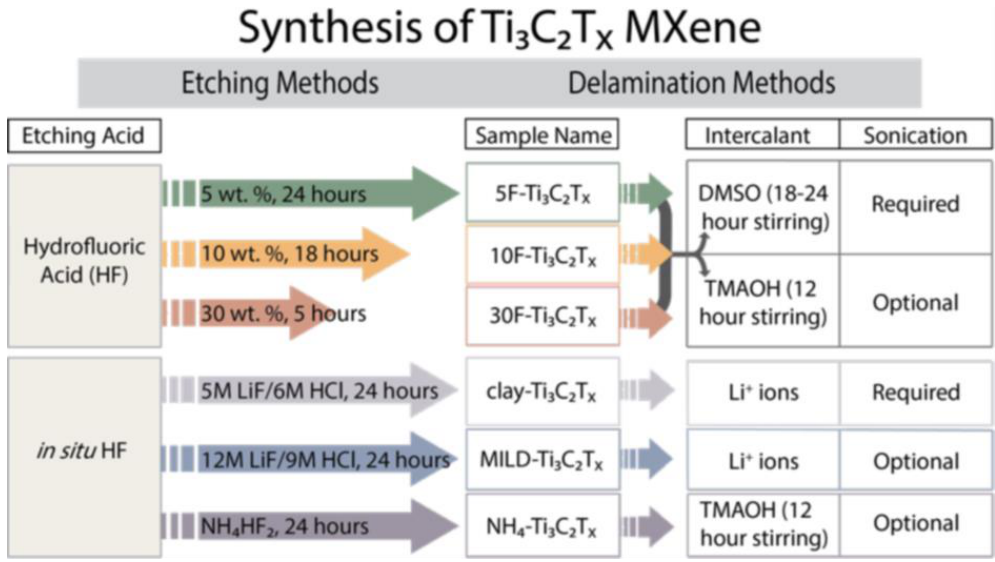
Figure 6. The general MXene synthetic route with both the HF and in−situ HF etching process and